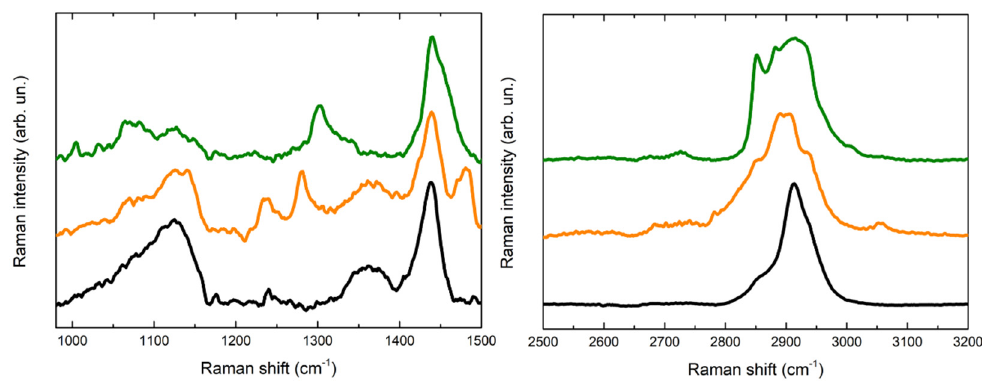
Figure 5. Comparison of three Raman spectra acquired for the reference of PVA-borax hydrogel. Figure 6. Comparison of Raman spectra acquired for the reference of PVA-borax hydrogel (black line), the cleaning gel for the cent stains on Carrara marble (orange line) and the cleaning gel for the penny stains on Travertine (green line).